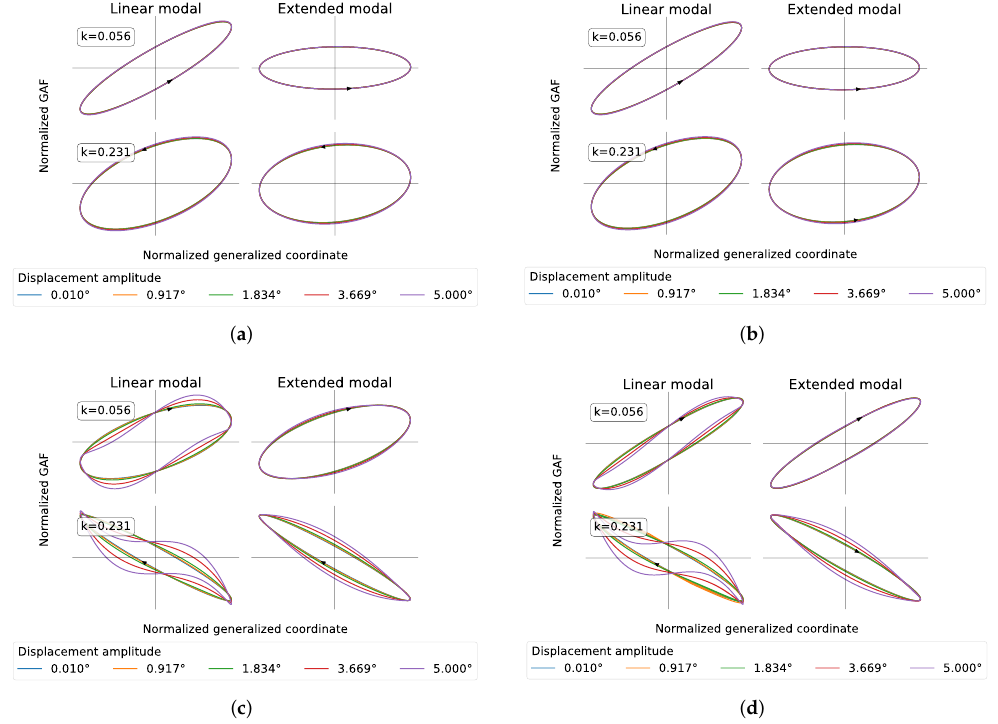
Figure 9. GAF hystereses (Inviscid flow, Mach 0.4) Figure 12. Impact of fluid viscosity on GAF hystereses (Mach 0.4). ( a ) Inviscid flow— Q ( b ) viscous flow— Q hh ( 1,1 ) ; ( c ) inviscid flow— Q hh ( 2,1 ) ; ( d ) viscous flow— Q hh ( 2,1 )